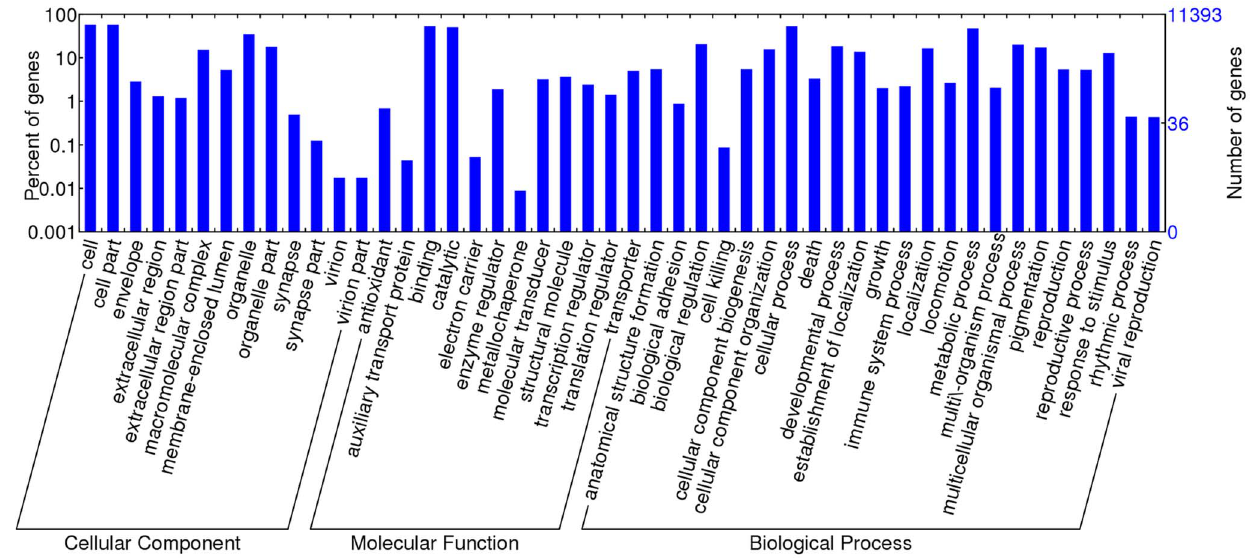
Figure 2. Gene ontology (GO) terms for the transcriptomic sequences of Blattellagermanica . doi:10.1371/journal.pone.0106932.g002 PLOS ONE |